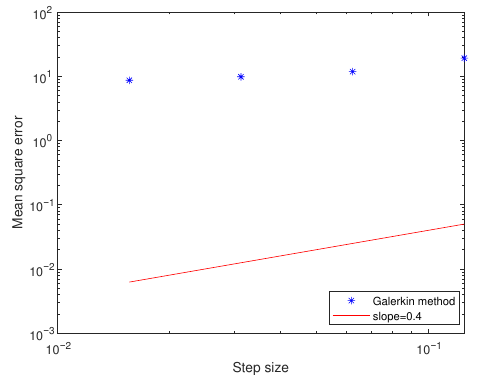
Figure 2. Loglog plot of errors against step